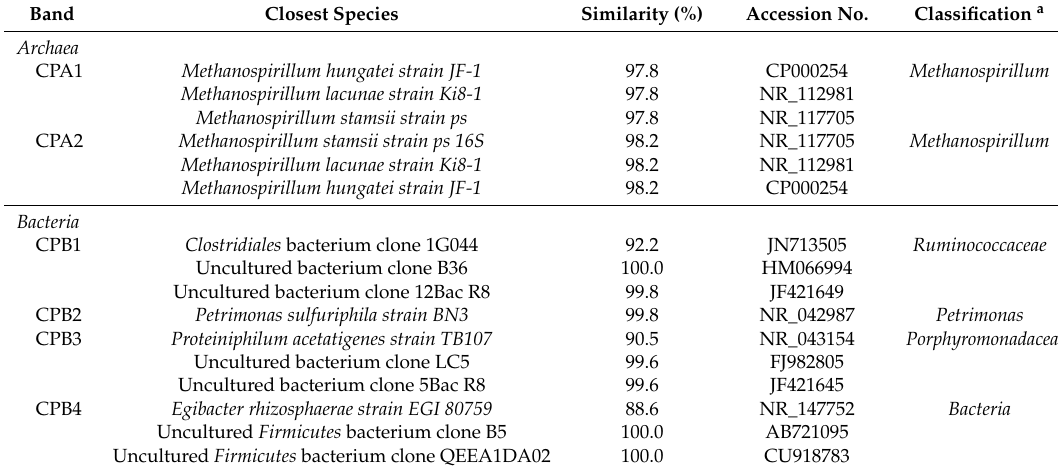
Table 6. Phylogenetic affiliation of archaeal and bacterial 16S rRNA gene sequences retrieved from the DGGE